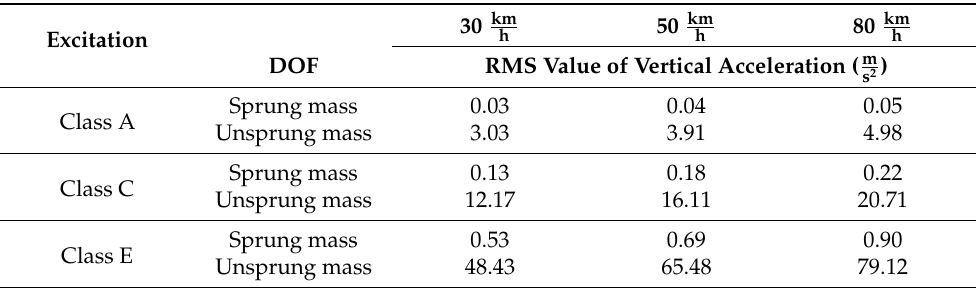
Table 10. The values of the RMS of acceleration of the sprung and the unsprung mass of the Quarter Car model for the stochastic excitations.